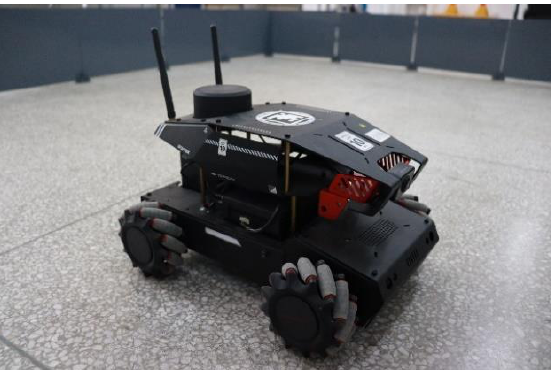
Figure 11. The Mecanum wheel omni-directional mobile robot U-car which was used in the experi-